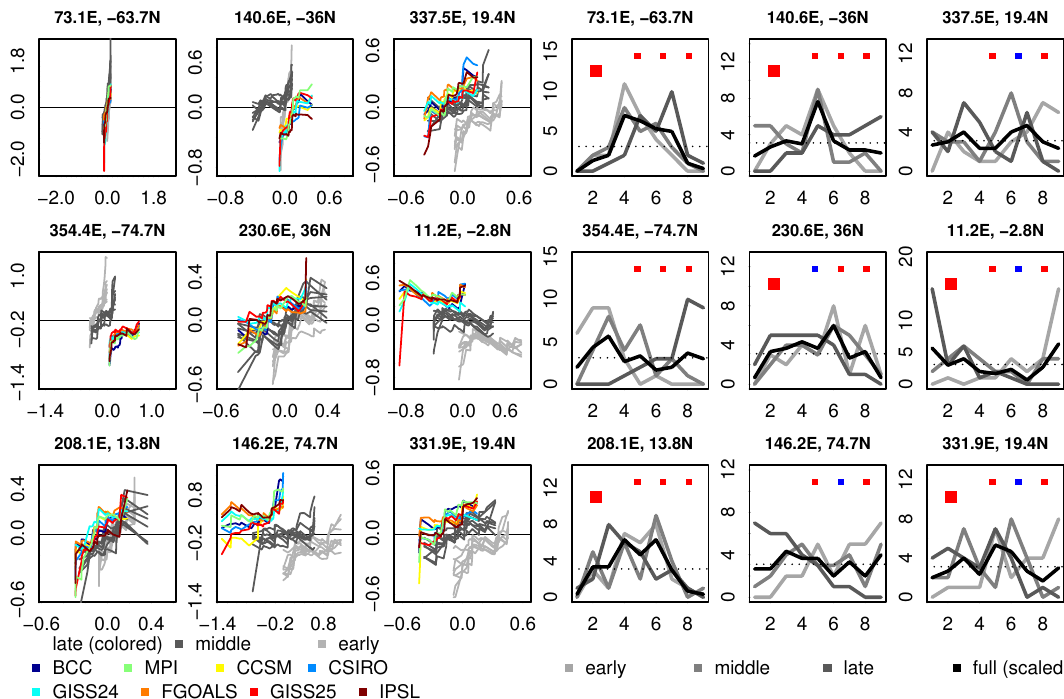
Fig. 2. Grid-point analysis of ensemble consistency for three sub-periods: 1000s–1270s, 1280s–1550s, and 1560s–1830s. Left three columns: residual quantile-quantile plots (units are in Kelvin, K) for a selection of grid points for the first (light grey), second (dark grey) and third (coloured) sub-periods. Right three columns: rank histogram counts for the selection of grid points for the three sub-periods (first to last, light to dark grey) and the full period (black, scaled to match frequencies in sub-periods). Large (small) red squares mark grid points where spread or bias deviations are significant over the full (from left to right the first to the third sub-)period. Blue squares mark deviations which are not significant. Residual quantile plots show on the x axis the quantiles of the target and on the y axis the difference between simulated and target